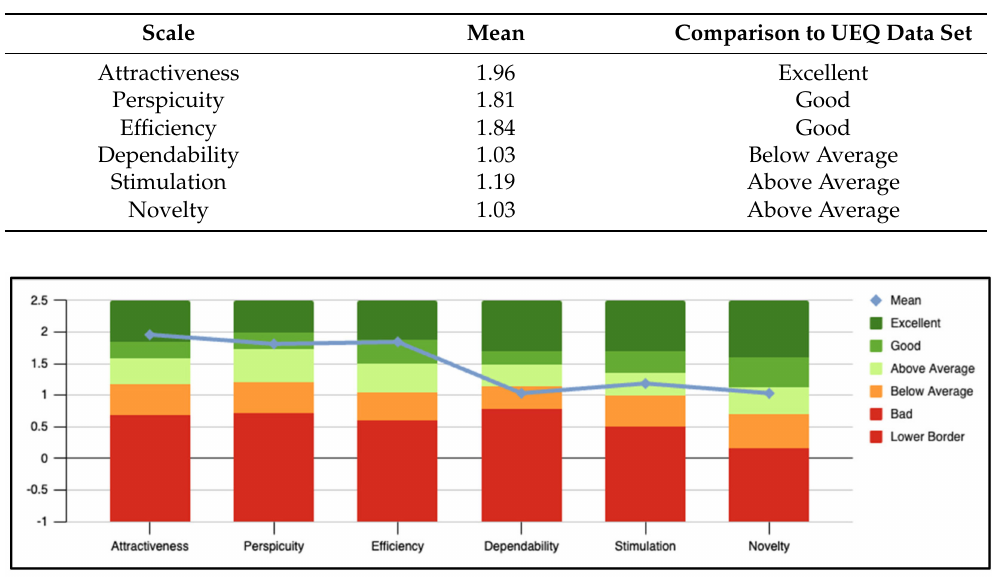
Figure 3. ACUX-R mean values per scale compared to the UEQ dataset.